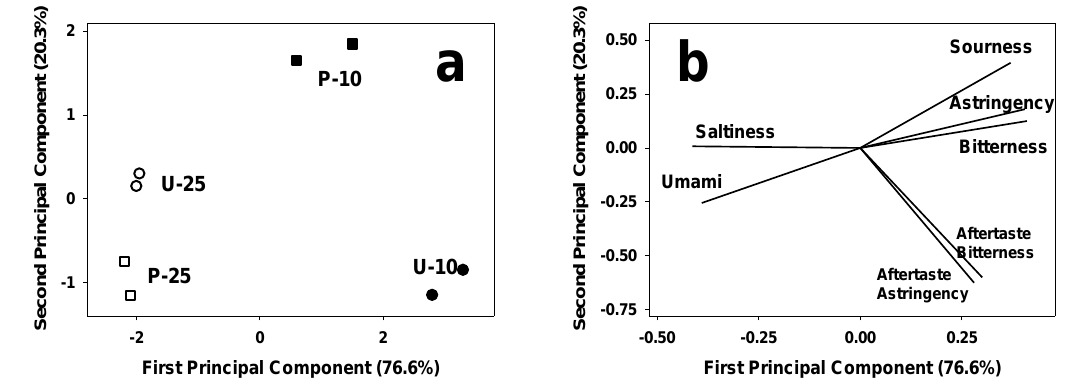
Figure 5. E-tongue PCA score plot ( a ) and loading plot ( b ). Samples are identified by letters (indicating the use of untreated (U) or parboiled (P) rice) and digits (10, 25) indicating the percent content in soybean flour.